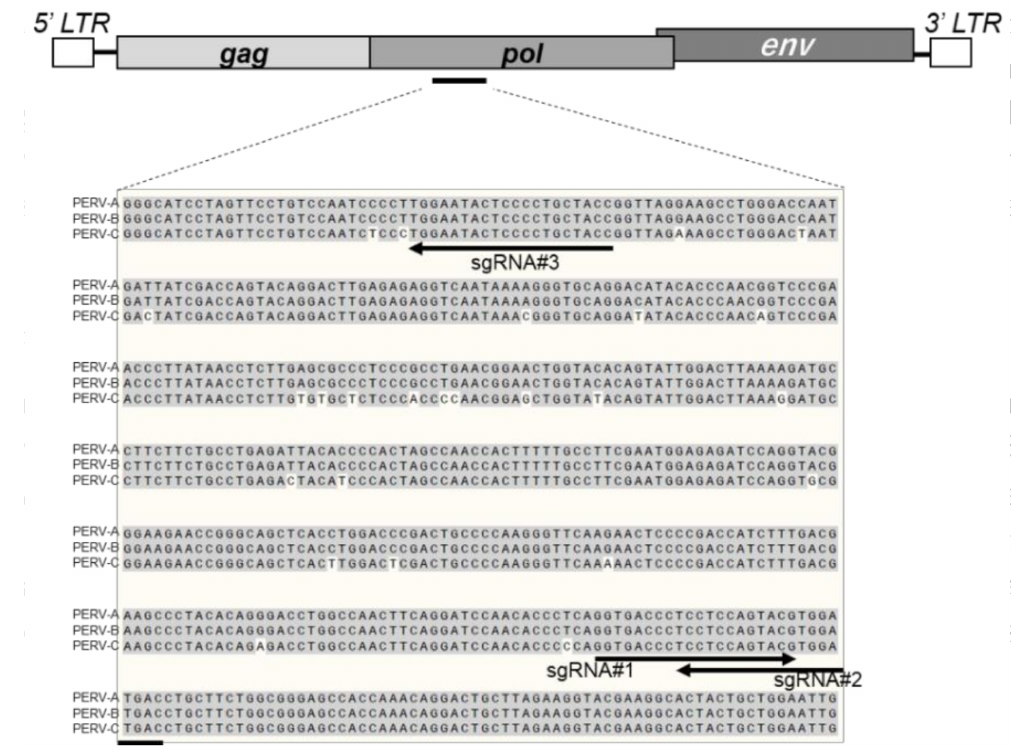
Figure 1. Genomic structure of porcine endogenous retrovirus (PERV) and gRNA locations targeting the pol gene. Three types of gRNAs (arrows) are shown in the alignments of PERV-A, PERV-B, and PERV-C pol genes.